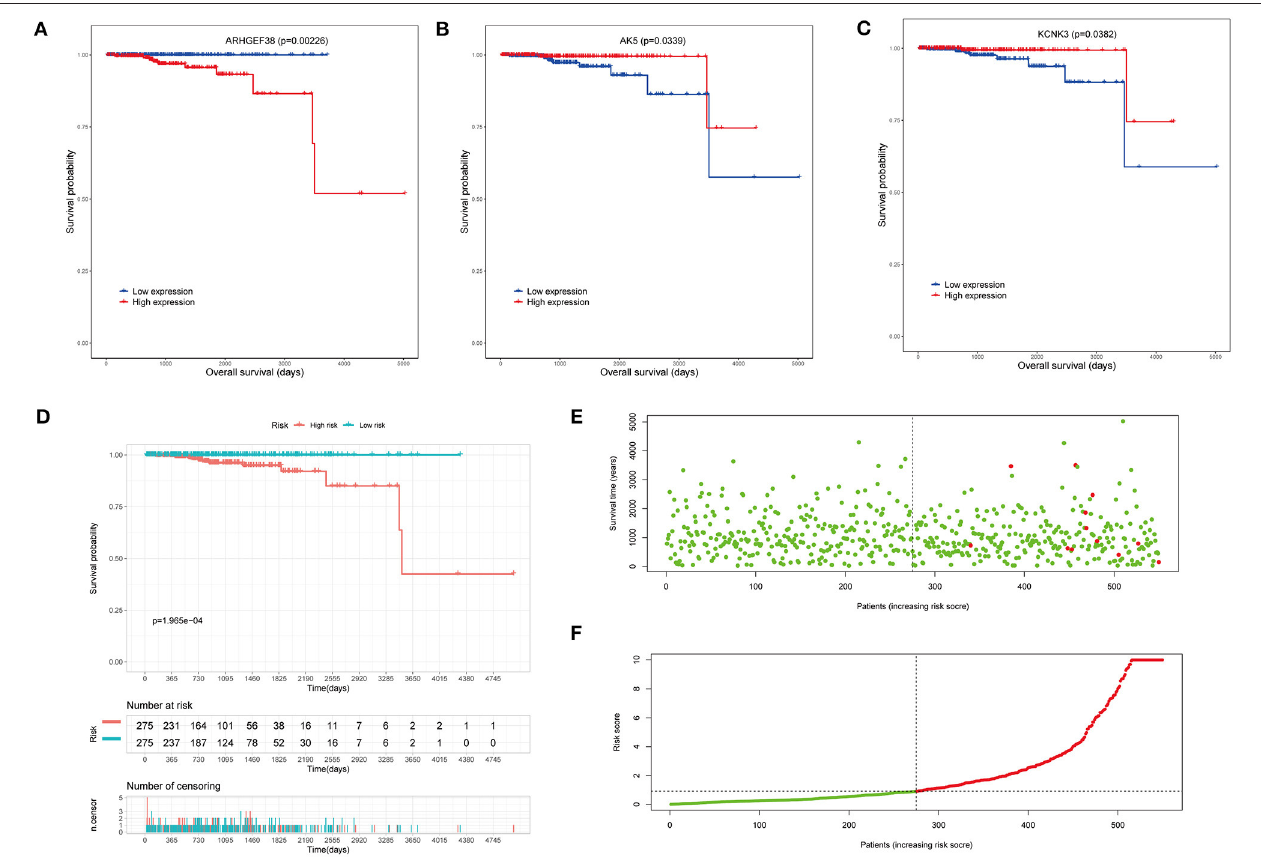
FIGURE 4 | Survival analysis of the risk model. (A–C) The overall survival (OS) analysis in high and low AK5 , KCNK3 , and ARHGEF38 expression samples. (D) Kaplan–Meier survival analyses show the OS of patients in the high-risk score and the low-risk score groups. (E,F) The risk plot between the high- and low-risk score